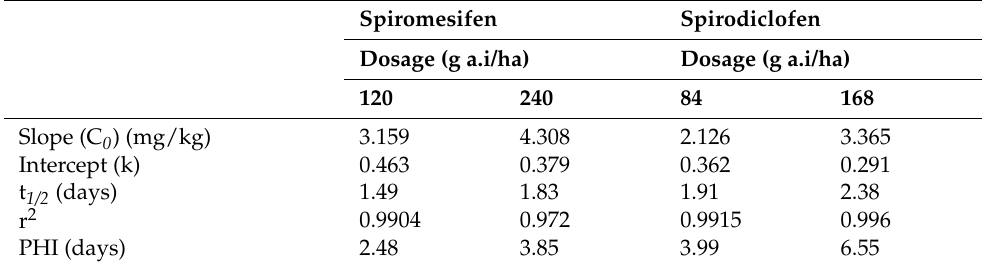
Table 4. Dissipation kinetics of spiromesifen and spirodiclofen in tomato fruits. Spiromesifen Spirodiclofen Dosage (g a.i/ha) Dosage (g a.i/ha)